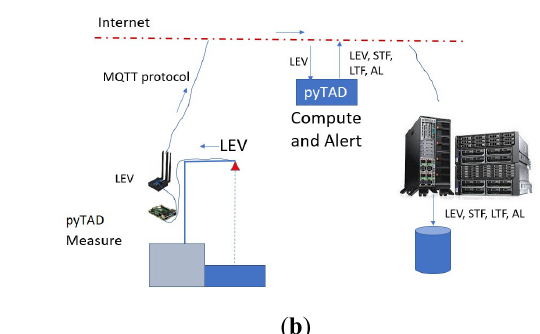
Figure 12. Results of the measurements and the calculated quantities from the Marina di Teulada IDSL during the event. The image is a screenshot of the published web data, which appeared online during the event.